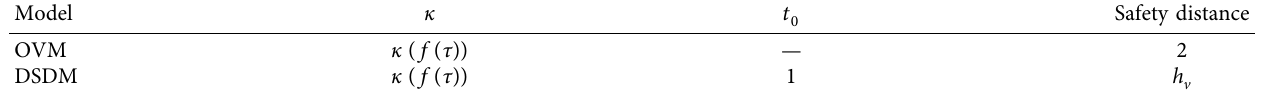
Table 3: Parameters of numerical simulation experiment when κ obeys log-normal distribution.